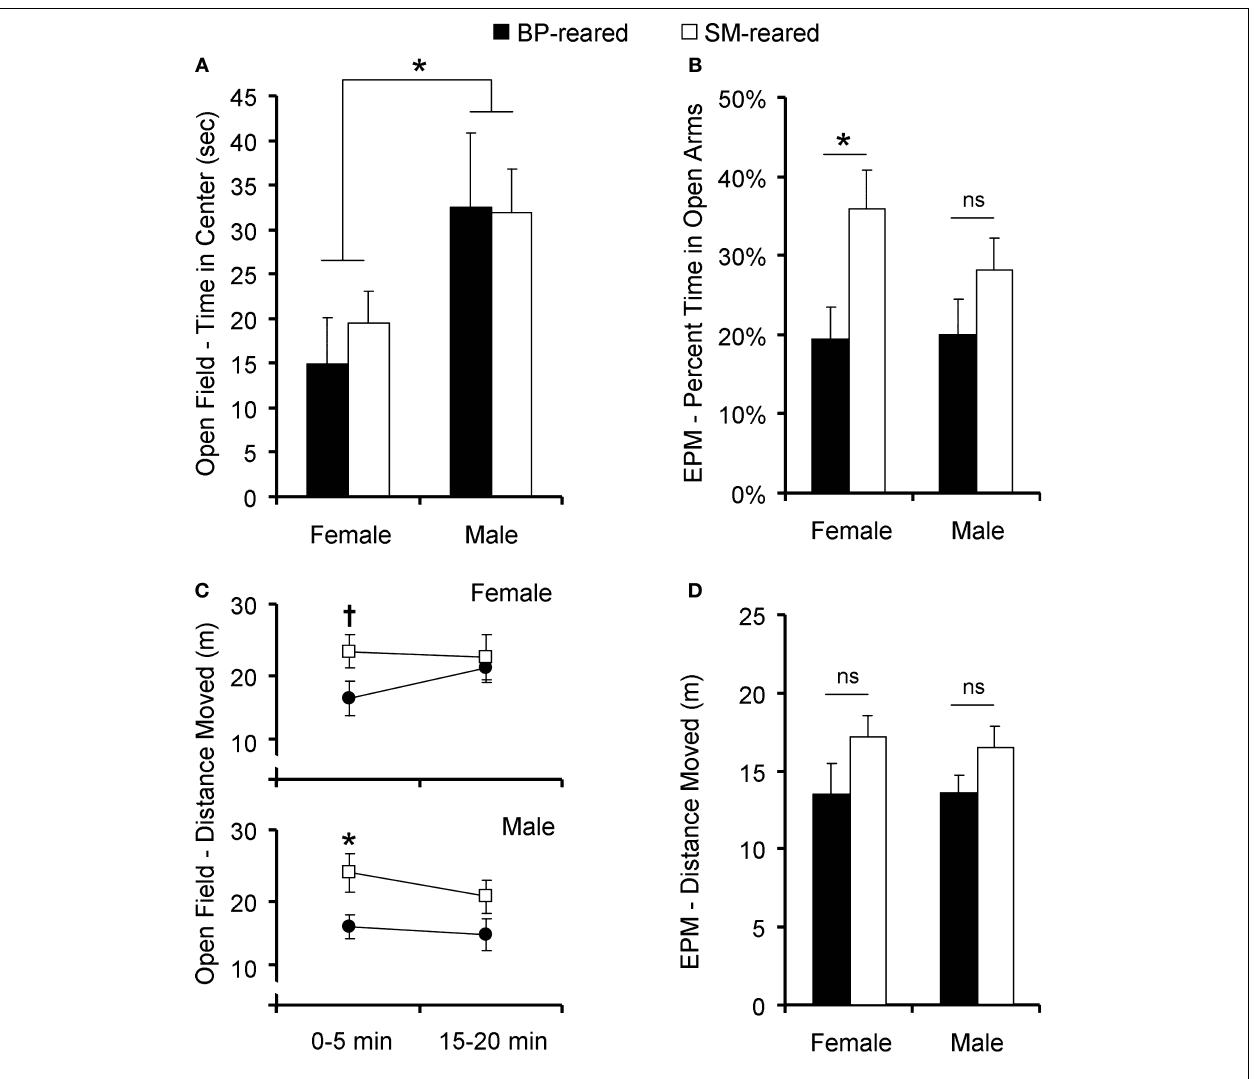
compared to BP-reared adult animals. In terms of locomotor activity, SM-reared adult animals of both sexes showed transient hyperactivity in both the fi rst 5 min of the open-fi eld test (C) and the 5 min EPM test (D) , compared to BP-reared counterparts. Bar graphs represent means + SEM. (cid:132) , BP-reared adult offspring; (cid:133) , SM-reared adult offspring. * P < 0.05, ns = not signifi